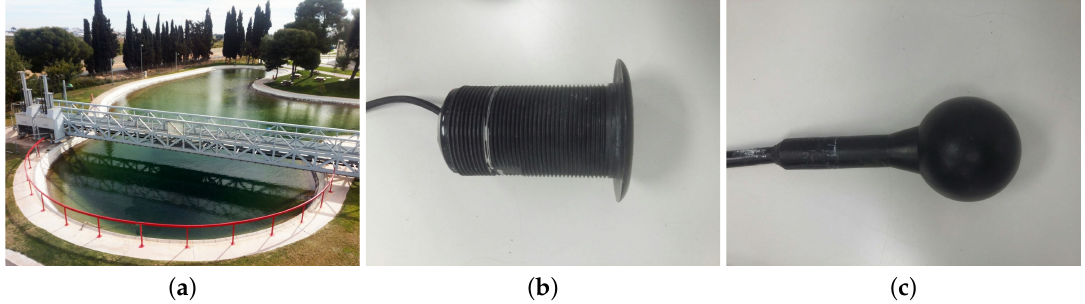
Figure 4. Location where the experimental measurements were made. ( a ) Lake; ( b ) Airmar P19 emitter; ( c ) ITC 1032